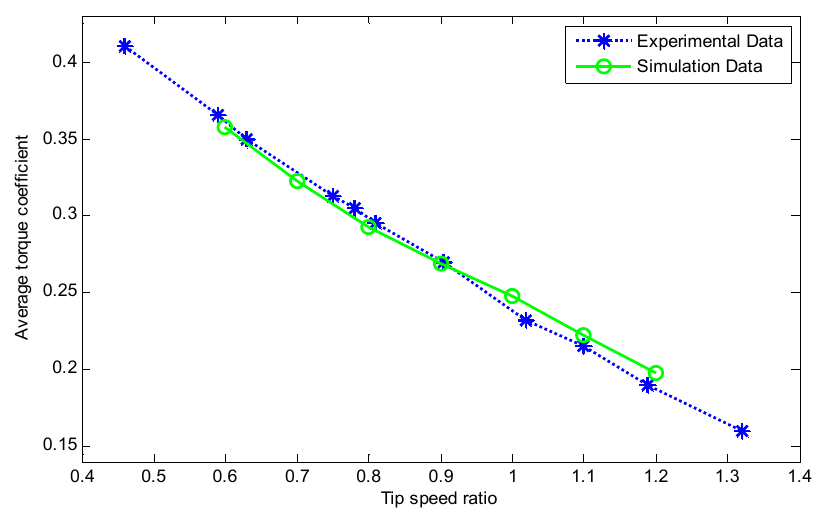
Figure 7. Comparison of the average torque coefficient at different tip speed ratios ( TSRs ).